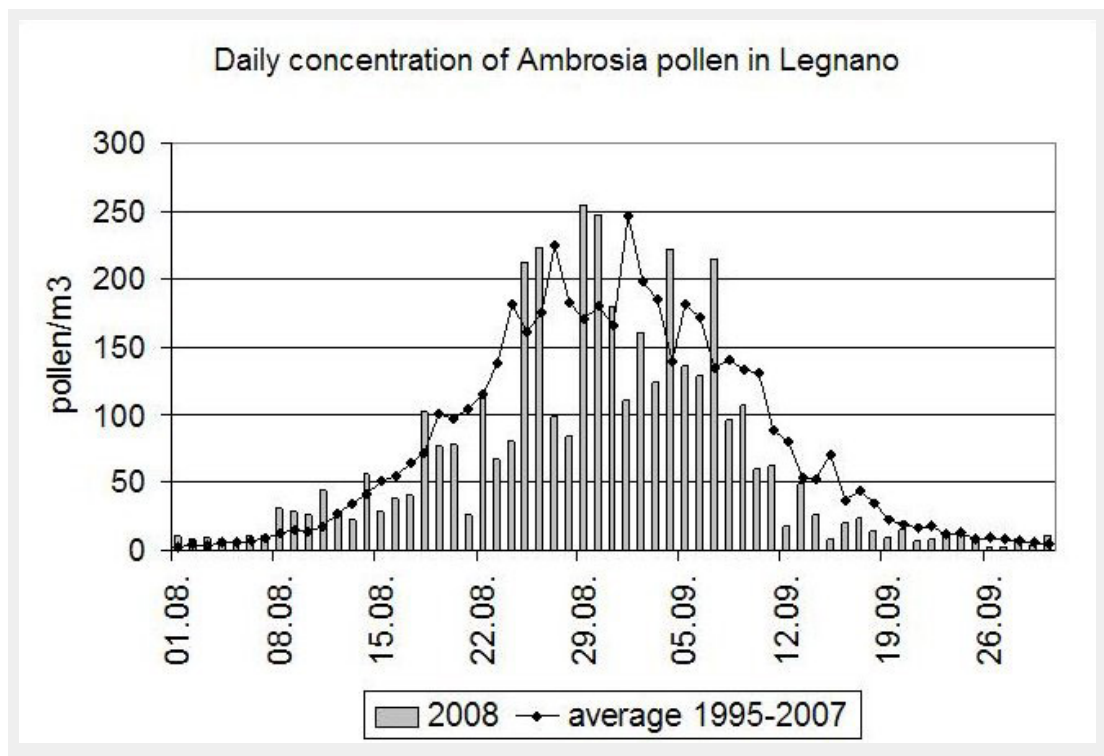
Figure 5 The daily concentration of Ambrosia pollen in Legnano in 2008 and the average daily concentration over the years